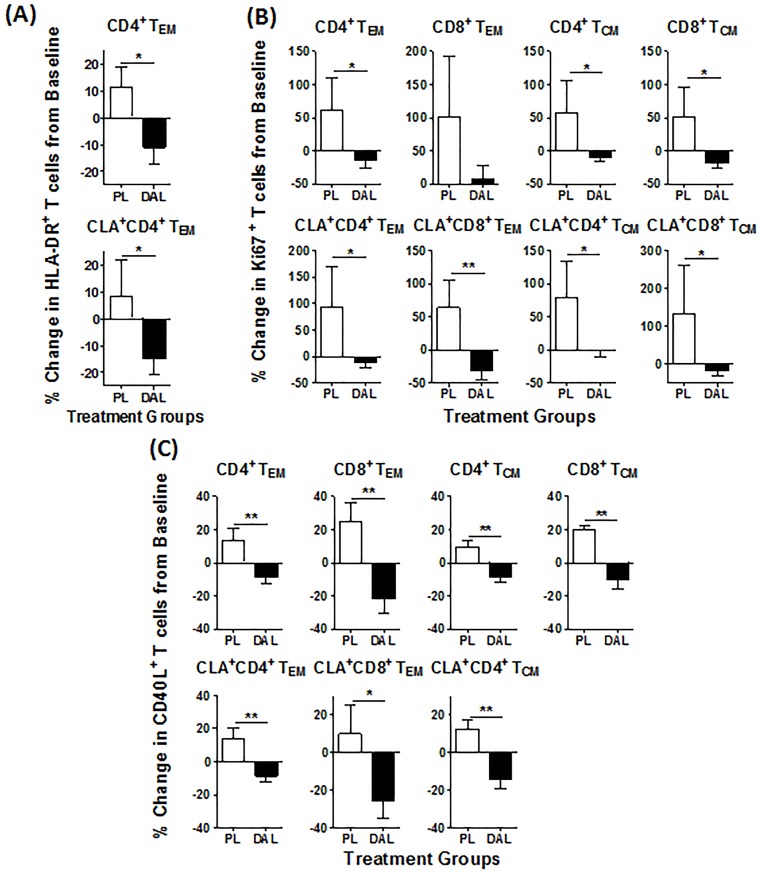
Dalazatide treatment reduces the expression of activation markers HLA-DR, Ki67 and CD40L by memory T cells from psoriasis patients.(A, B) The proportion of CD2+ memory T cells from the peripheral blood from placebo (PAL) and dalazatide (DAL, 60 μχγ/dose) treated patient samples were analyzed for the proportion of the indicated subpopulation and the % change from Day 29 relative to Day 1 calculated. A) HLA-DR expression, B) Ki67 expression, C) CD40L expression after PMA/ionomycin treatment. Samples were collected on Day 1 pre-dose and Day 29 post-dose. The CD40L+ populations as a percentage of CD4+ or CD8+ memory T cells were measured following an ex vivo culture of PBMC with 0.2 nM PMA and ionomycin (250 ng/mL) or media alone for 6 hours. The percentage of cells expressing CD40L in response to PMA/ionomycin was calculated as: %CD40L+(stimulated) = %CD40L+(PMA+Ionomycin)-%CD40L+(Media alone). Data represent the mean ± SEM of the % change from Day 29 relative to Day 1. Statistical analysis between placebo and dalazatide groups was performed using one-tailed Student’s t-test. *P < 0.05. **P<0.01